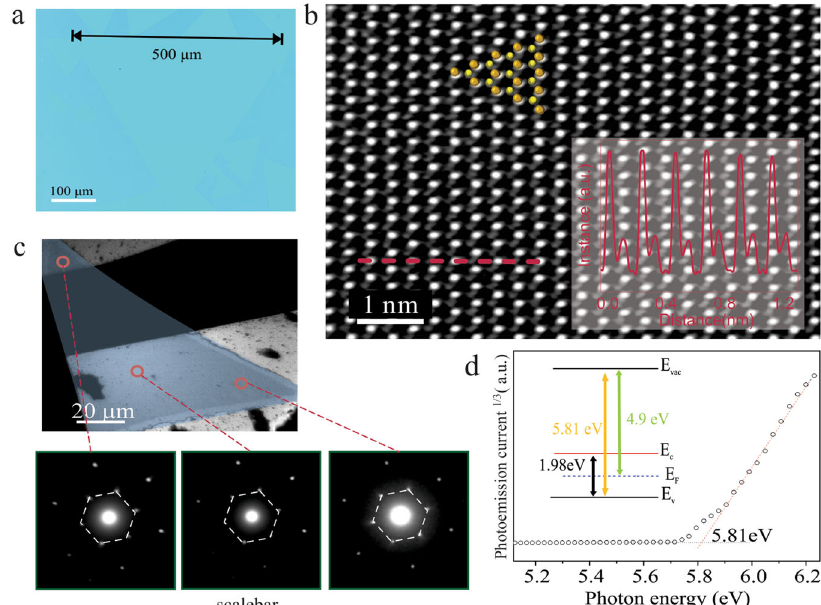
Fig. 4 Detailed characterization of mediator-grown WS 2 . a Optical micrograph of individual fl ake obtained after short growth duration. b Aberration corrected TEM image of lattice structure with indication of crystal orientation, (inset) cross-sectional trace of intensity. c False- color TEM image of single-crystalline fl ake, with corresponding SAED patterns at different locations indicating its single crystallinity. d Determining valence band edge through linear extrapolation of cubic root of photoelectron emission vs photon energy 48 , (inset) experimental band structure with Fermi level extracted from Kelvin-probe measurements.